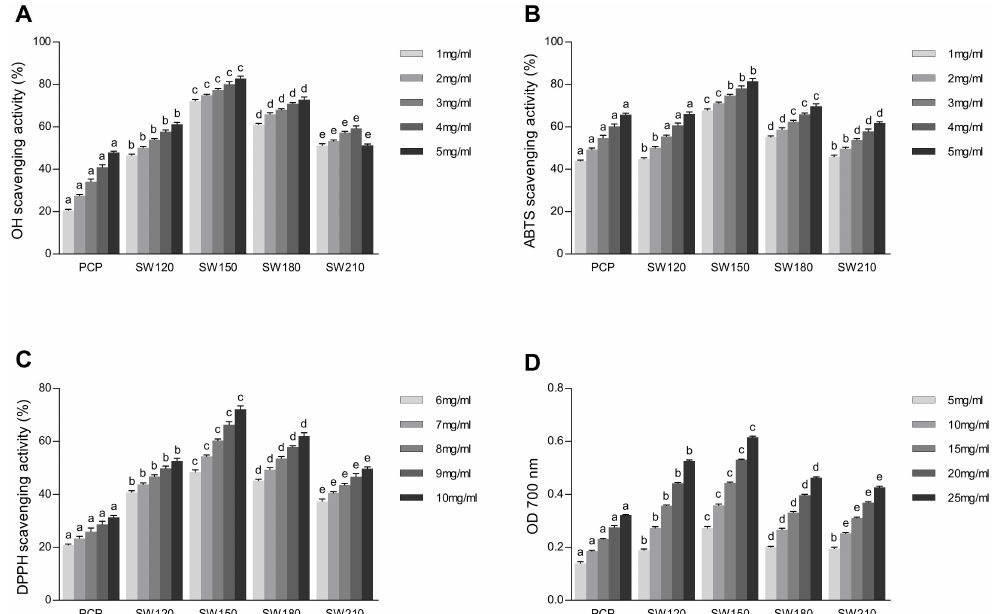
Figure 5. Scavenging effect of pumpkin polysaccharides on hydroxyl radical ( A ), ABTS radical ( B ), DPPH radical ( C ), and reducing power ( D ). Data were expressed by means ± SD ( n = 3). Values with different letters in the same concentration column differ significantly ( p < 0.05). PCP, pumpkin crude polysaccharides; SW120, PCP under SCW 120 ◦ C treatment; SW150, PCP under SCW 150 ◦ C treatment; SW180, PCP under SCW 180 ◦ C